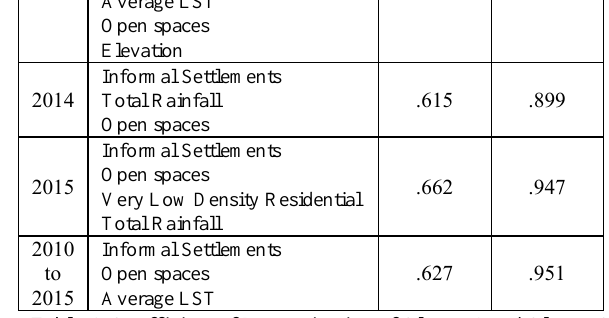
Table 4. Coefficient of Determination of Cluster 1 and Cluster 2 for each year and whole period using the significant predictors